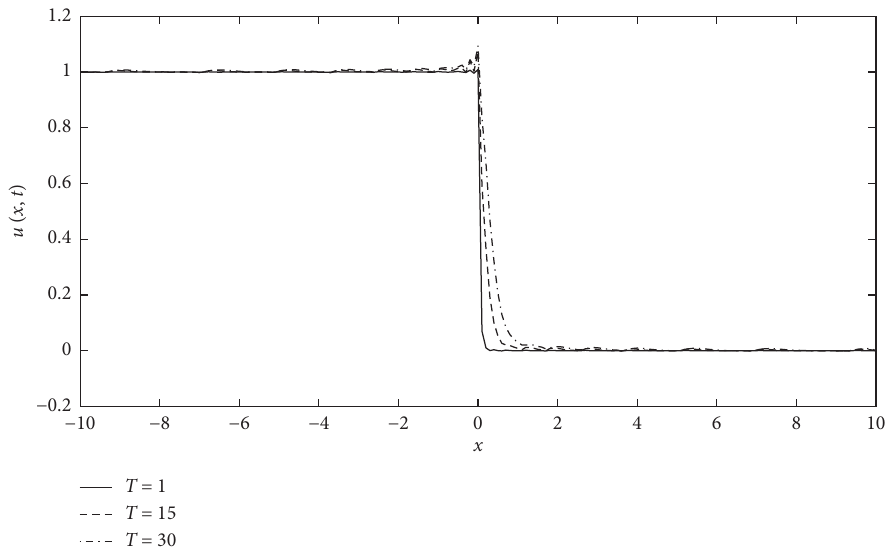
Figure 6: The numerical solutions of Example 3 with α � 0 . 9and N � 200 at T � 1 ,T � 15 , and T �